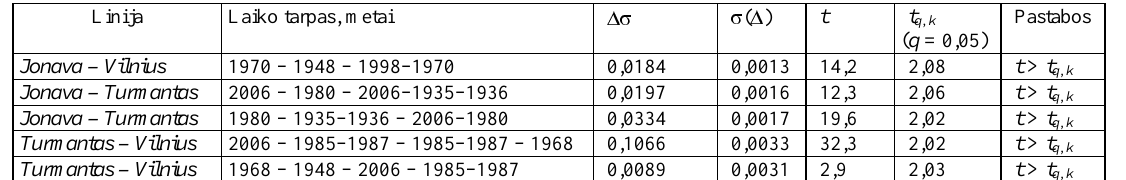
Table 3. The differential analysis of the vertical earth surface movements speed regressive models Linija Laiko tarpas, metai